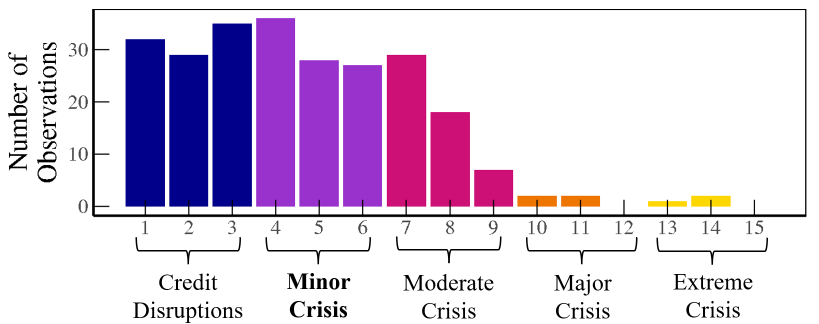
Figure 2. Romer and Romer (2017) . Note: The figure shows the number of observations for each crisis severity level (1–15) and type defined by Romer and Romer (2017): credit disruption, minor crisis, moderate crisis, and major/severe crisis. The most frequent crisis level is 4, and the majority of crises are categorized as credit disruptions or minor